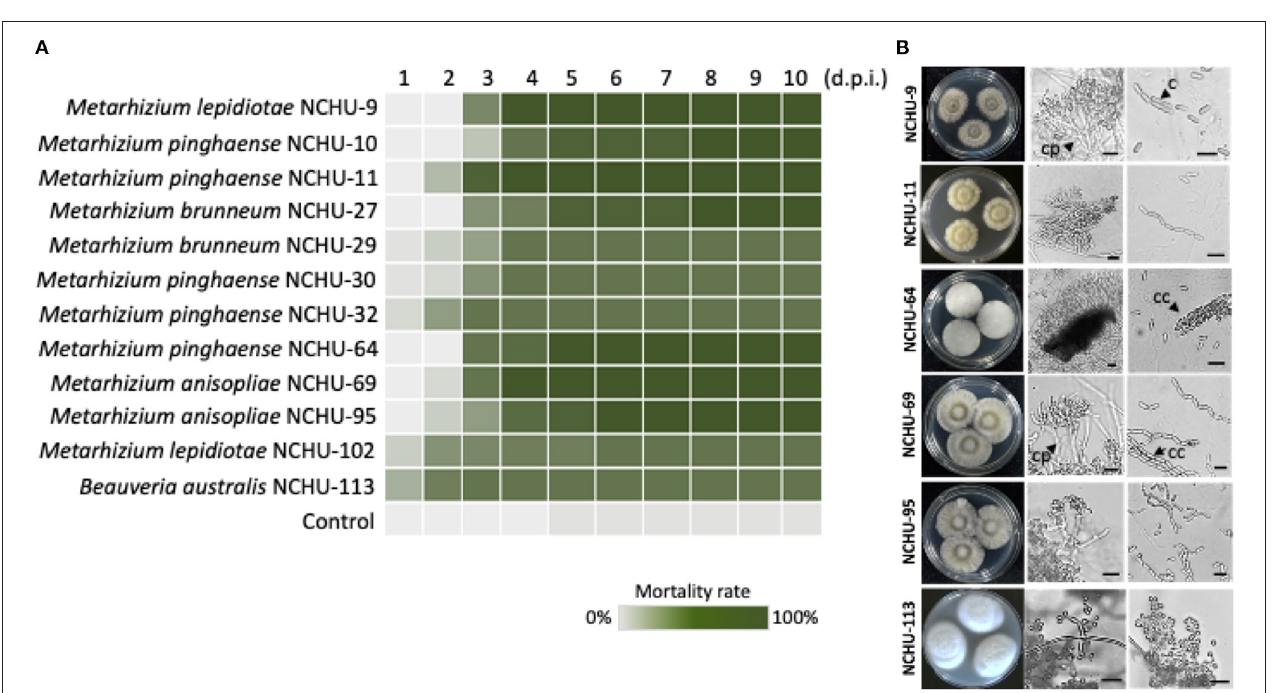
FIGURE 5 | Mortality heat map of 12 fungal isolates against S. litura . (A) Each fungal strain was repeated three times. d.p.i., days post inoculation. Six entomopathogenic fungal isolates were selected for morphological observation. (B) The fungal colony growth characteristics are shown in parallel. Cp, conidiophores; c, conidium; cc, cylindrical conidia. Scale bar = 10 µ